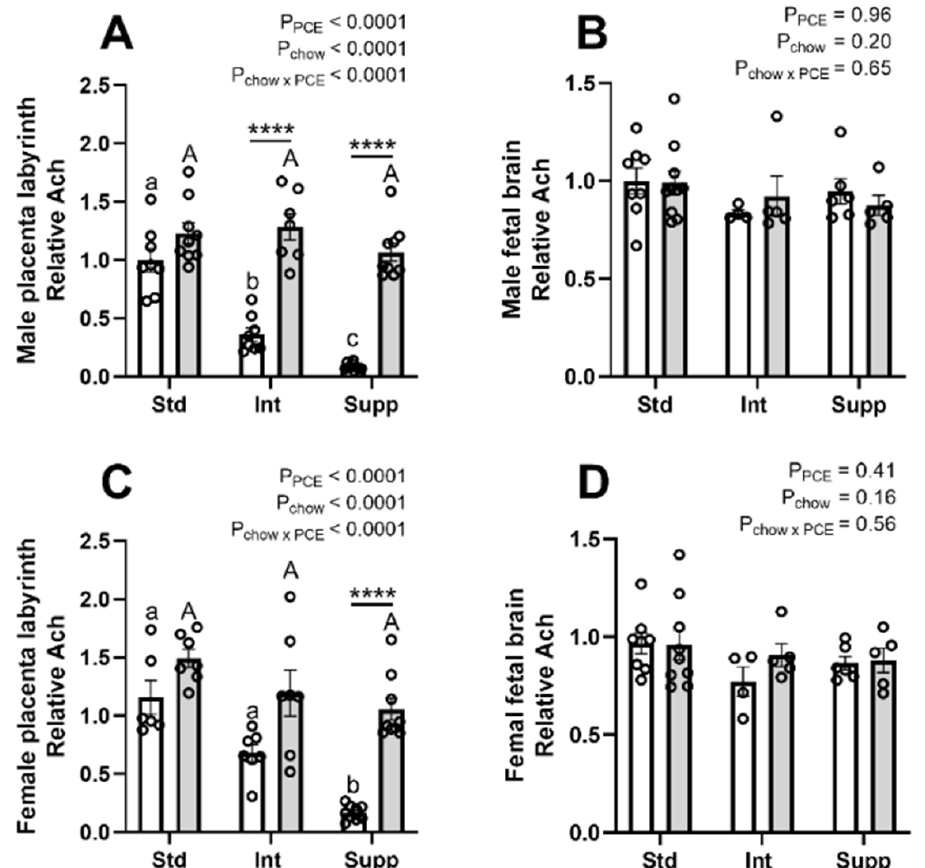
Figure 7. The effects of periconceptional ethanol and choline supplementation on acetylcholine (Ach) levels in placentas of male and female fetuses ( A , C ) and male and female fetal brain ( B , D ). During the periconceptional period, dams received a control liquid diet (Con; open bars) or a liquid diet containing 12.5% v / v ethanol (PCE; grey bars). For the remainder of pregnancy, dams received either standard chow (Std), intermediate chow (Int), or supplemented chow (Supp), with increasing levels of choline across these groups (1.6 g, 2.6 g, or 7.2 g choline/kg chow), n = 6–9 per group. Molecules were measured using mass spectrometry and data expressed as fold-change relative to the average of the male Std-Con group (mean ± SEM). Significant differences due to alcohol exposure or chow group were identified via two-way ANOVA and Tukey’s post hoc analysis. **** p < 0.0001 for differences between Con and PCE within each chow group; chow effects between Con groups are shown by lower-case letters, and between PCE groups by upper-case letters. TMAO was decreased by PCE in the placentas of both male (Figure 8A) and female (Figure 8E) fetuses, regardless of the chow group. Prenatal choline increased TMAO to a greater degree in control placentas than PCE-exposed placentas, particularly in the placentas of males. In the fetal compartment, modest choline supplementation (Int group) did not alter TMAO. However, additional supplementation (Supp group) resulted in a ~15-fold increase in TMAO in both male and female fetal plasma (Figure 8B,F) and a ~7 to 8-fold increase in the fetal liver (Figure 8C,G) and brain (Figure 8D,H). PCE resulted in a reduction in TMAO in the fetal liver of males only. TMAO was not measured in maternal